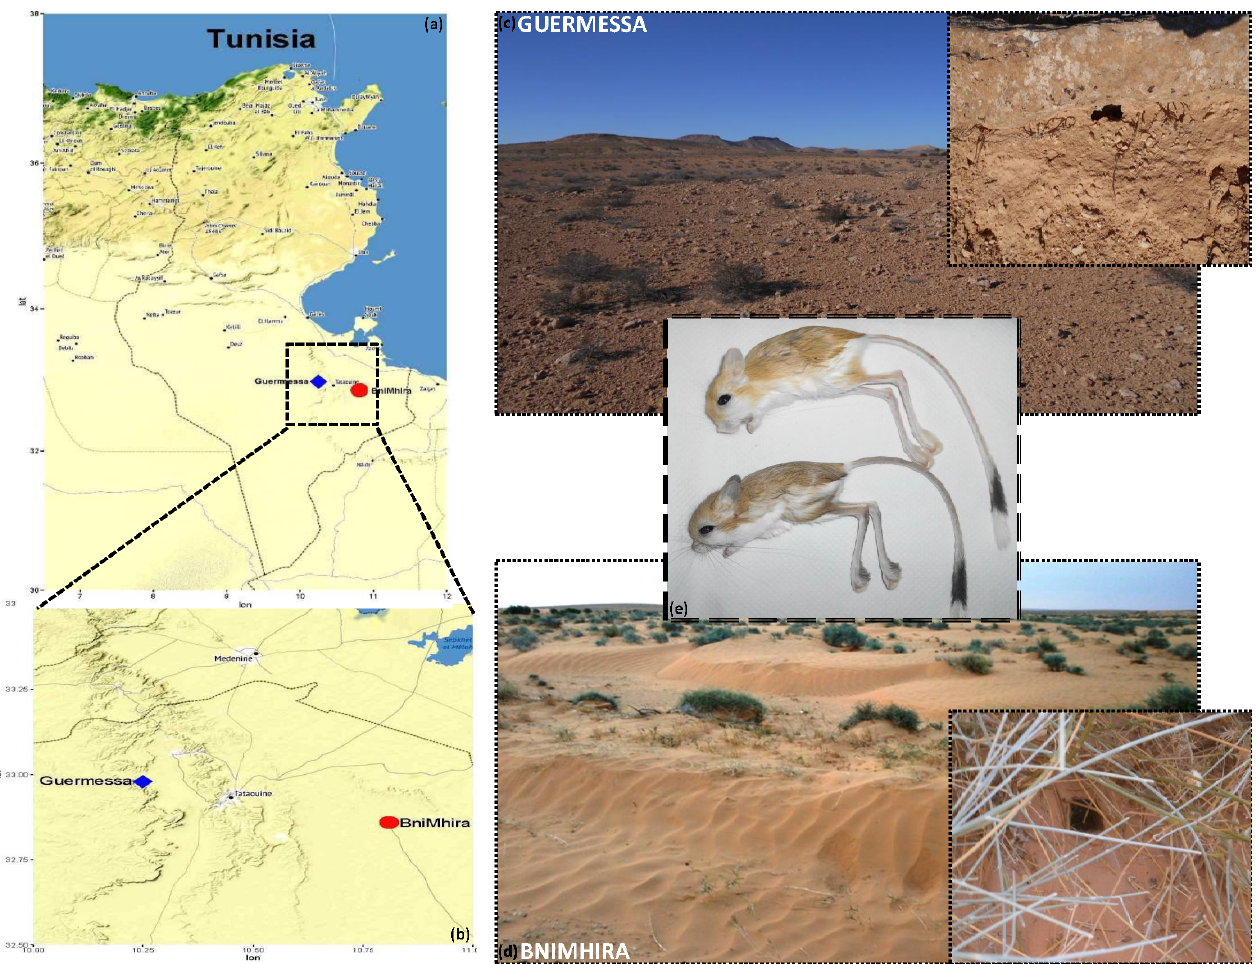
Figure 1. Study sites of Jaculus species. ( a ) Image of the location of the study area (determined by icons) at Tataouine Governorate. ( b ) Zoom into the locations of the two study sites highlighting the mountainous relief of Guermessa and Saharan relief of BniMhira. ( c ) The study site of Guermessa emphasizes rodents’ burrows. ( d ) The study site of BniMhira emphasizes rodents’ burrows. ( e ) The Tunisian Jaculus species: Jaculus jaculus (the one at the top of the image) and Jaculus hirtipes (the one at the bottom of the image), showing morphological and color differentiation between the two spe- cies.